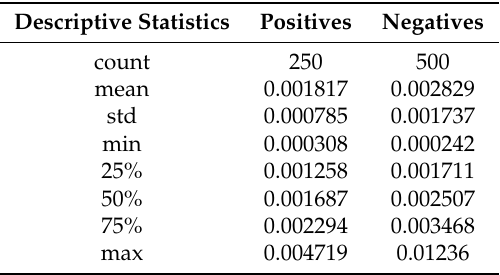
Table 1. Descriptive statistics of reconstruction errors for positives and negatives samples during the evaluation process.